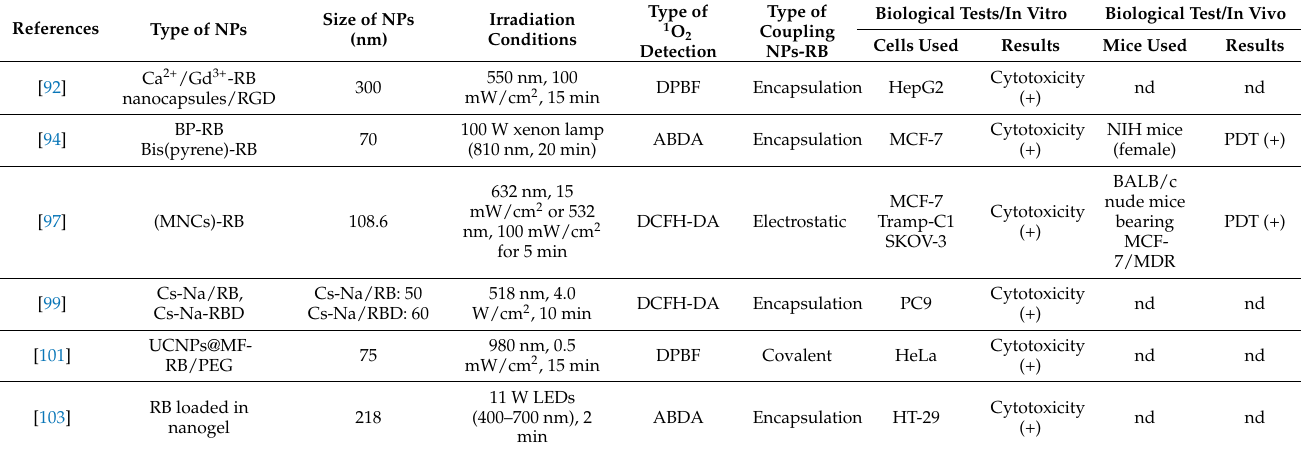
Table 6. References dealing with nanogel@RBs, nanogels, nanohybrid NPs, pH-sensitive NPs, magnetic NPs, nanocomplexes, nanocapsules, including type of NPs, along with their size, excitation wavelength, type of detection of 1 O 2 , the type of coupling between the NPs and the RB, and the type of biological tests